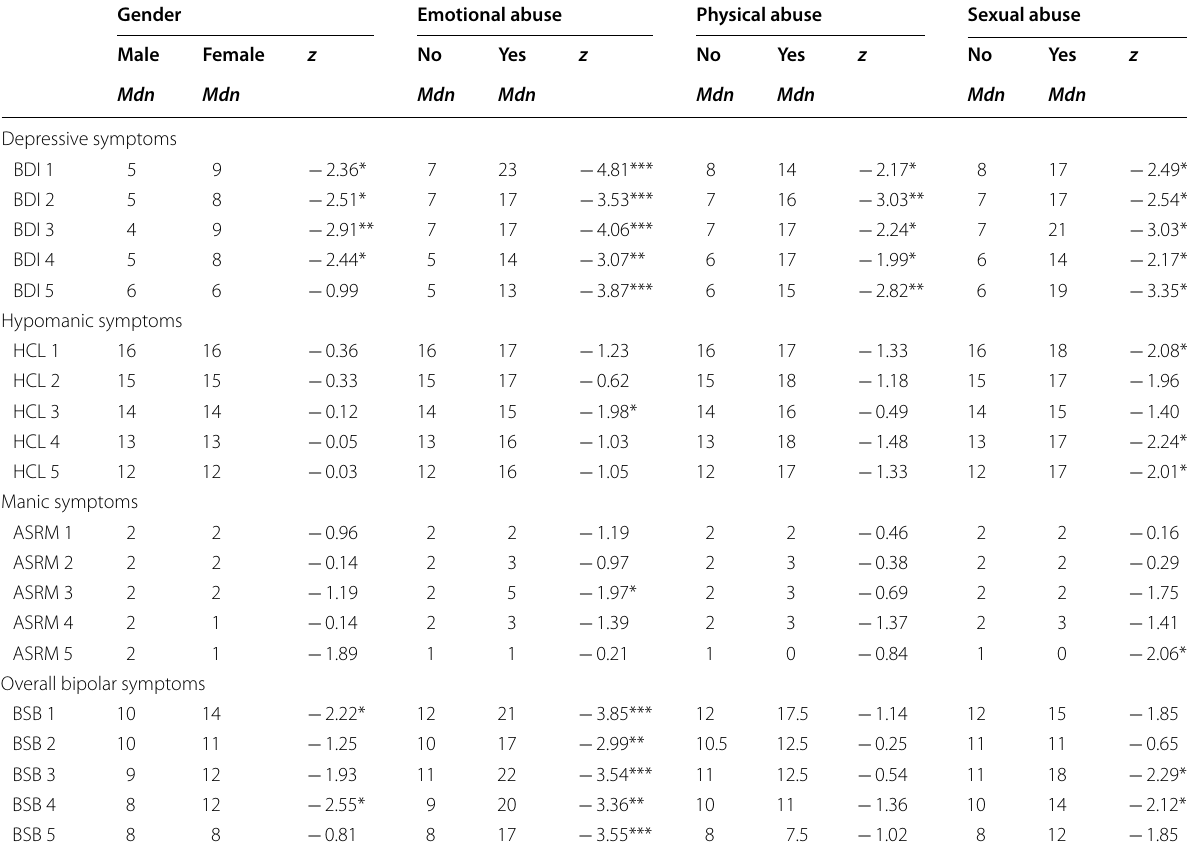
Table 3 Differences in depressive, hypomanic, manic and overall bipolar symptoms depending on gender and childhood